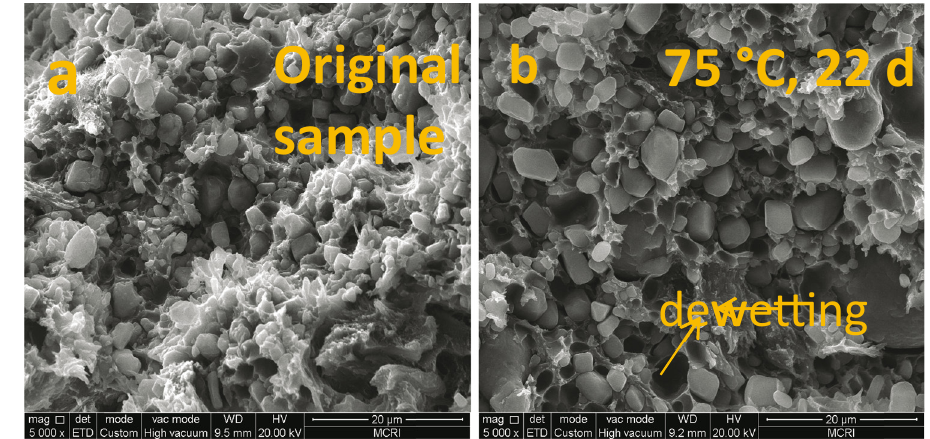
Figure 11: FESEM images of GaTo impact fracture section before ( a ) and after ( b ) aging at 75°C for 22 days.